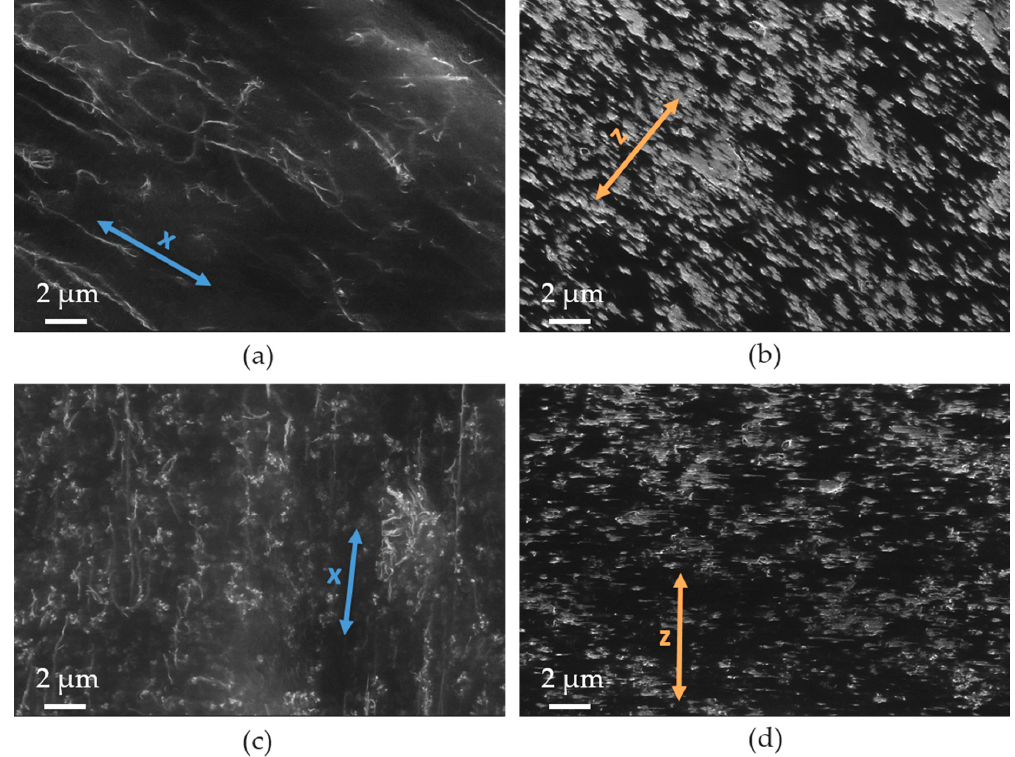
Figure 5. SEM-charge contrast imaging mode (CCI) images of extruded PVDF1 films: ( a , b ) PVDF1/2 wt % b-MWCNT, ( c , d ) PVDF1/1 wt % b-MWCNT + 1 wt % CB, ( a , c ) surface, arrows indicate the x-direction and alignment direction of CNTs, ( b , d ) cross-section, arrows indicate the z-direction of the film, the CNTs and CB aggregates are aligned perpendicular to the z-direction.